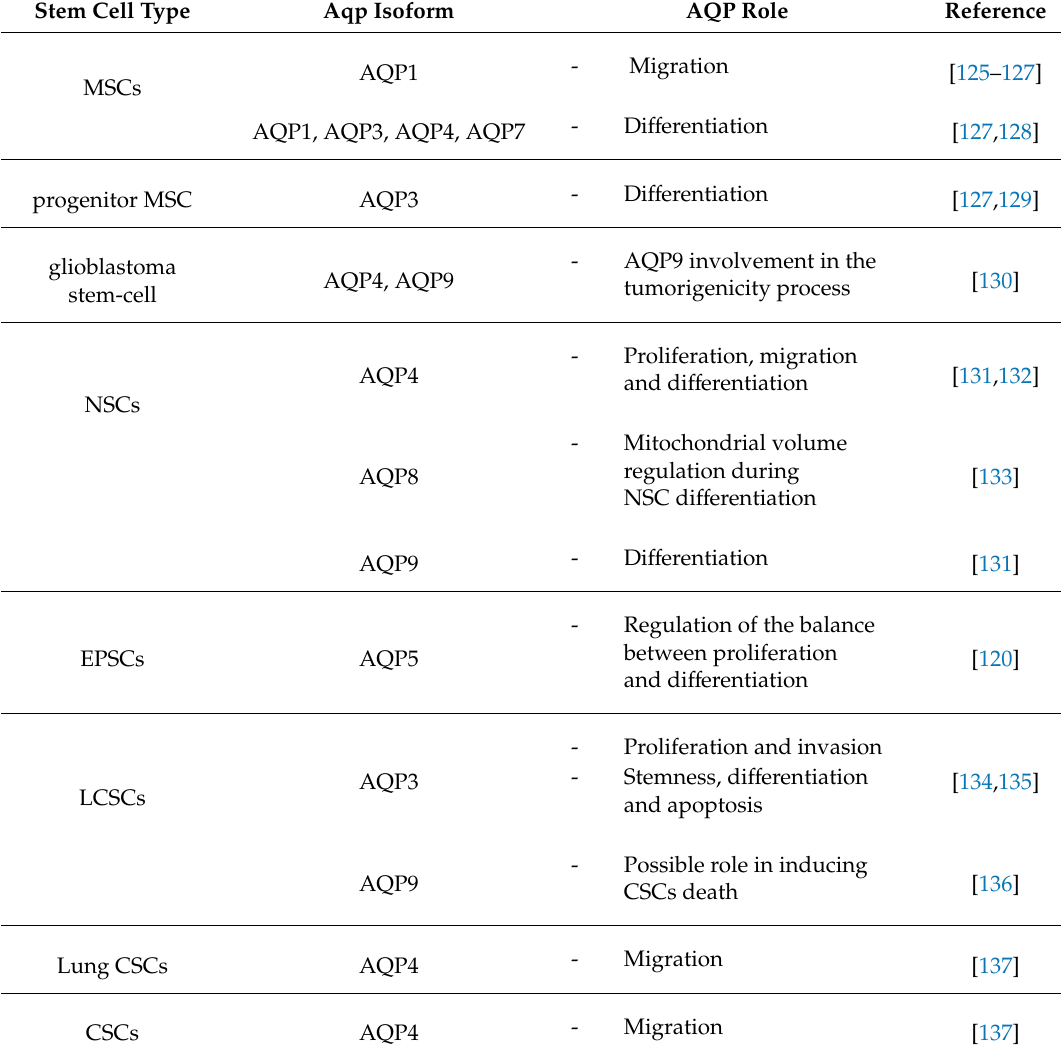
Table 3. Involvement of AQPs in di ff erent aspects of stem cell biology in health and